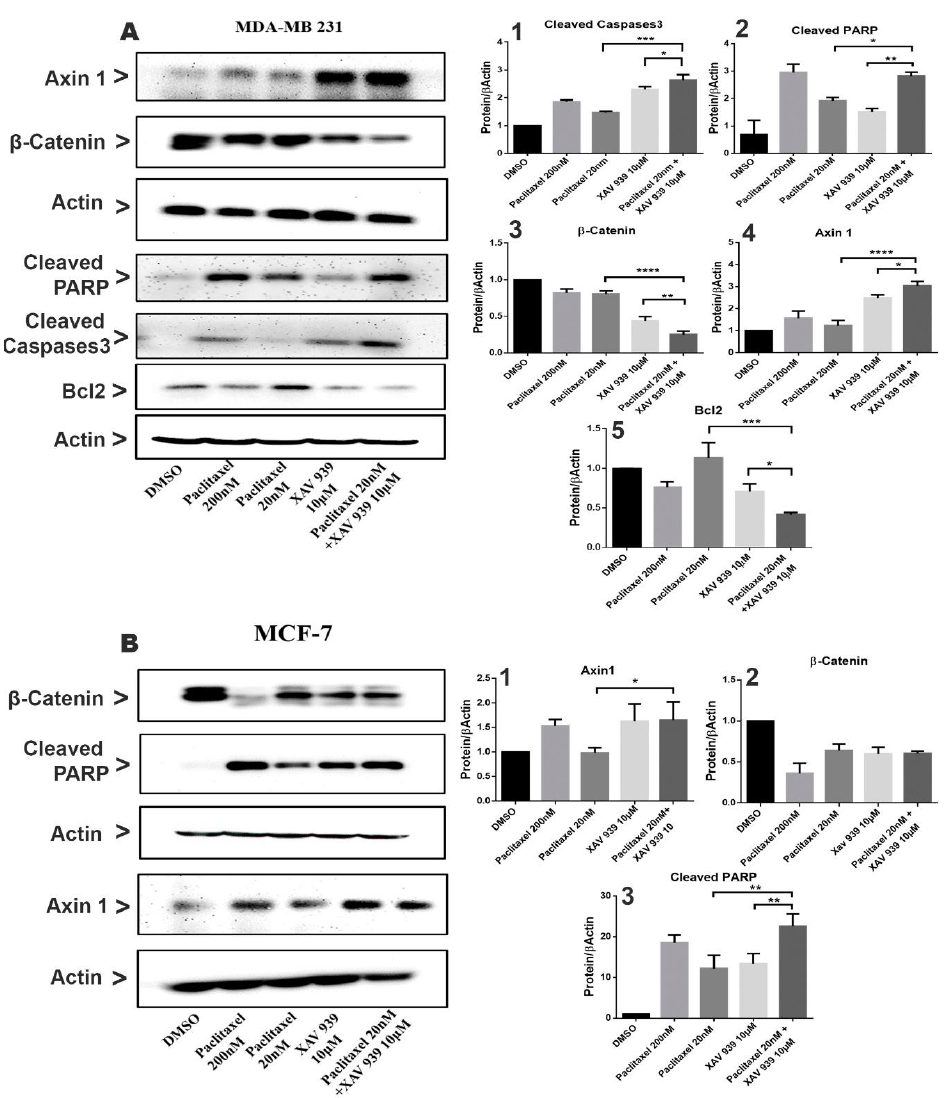
Figure 3. Combination treatment suppressed the Wnt signaling pathway and induced apoptosis in MDA-MB-231 and MCF-7 by the caspase-dependent pathway. ( A ) MDA-MB-231 cells were treated with paclitaxel and / or XAV939 for 48 h, and protein expression levels of β -catenin, Axin1, cleaved PARP, Bcl2, and cleaved caspases3 were analyzed using the Western blot. ( B ) The expression levels of β -catenin, Axin1, and cleaved PARP were analyzed in MCF-7 after treatment with paclitaxel and / or XAV939 for 48 h. All bar graphs represent the protein expression levels, which were quantified by densitometry from three di ff erent experiments and normalized to the expression level of actin. Results are expressed as mean ± SD (n = 3). *: p < 0.05; **: p < 0.01; ***: p < 0.005; ****: p < 0.001 in comparison to each single treatment with paclitaxel or